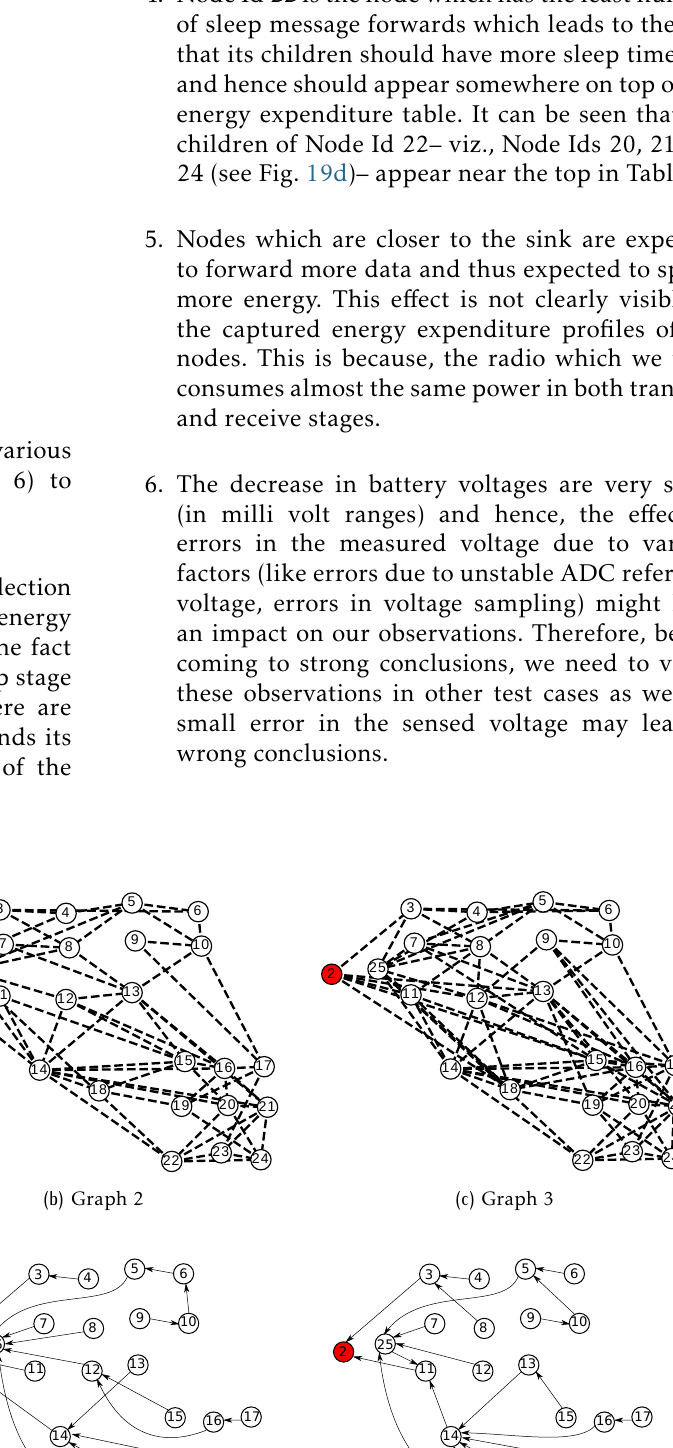
Figure 24. Consecutive graphs and respective data collection trees for test case